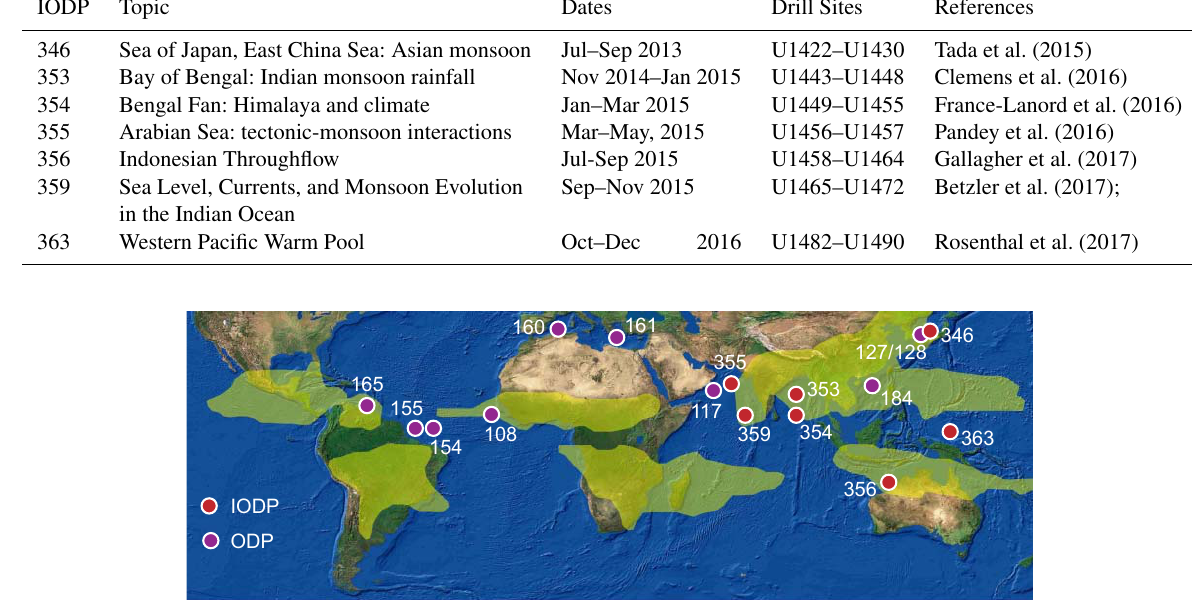
directions, and made recommendations for the future IODP science program (Fig.